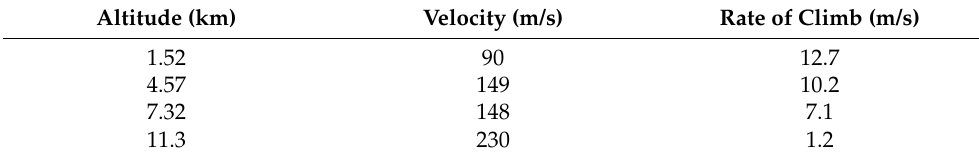
Table 4. A320 climb parameters compiled using data from